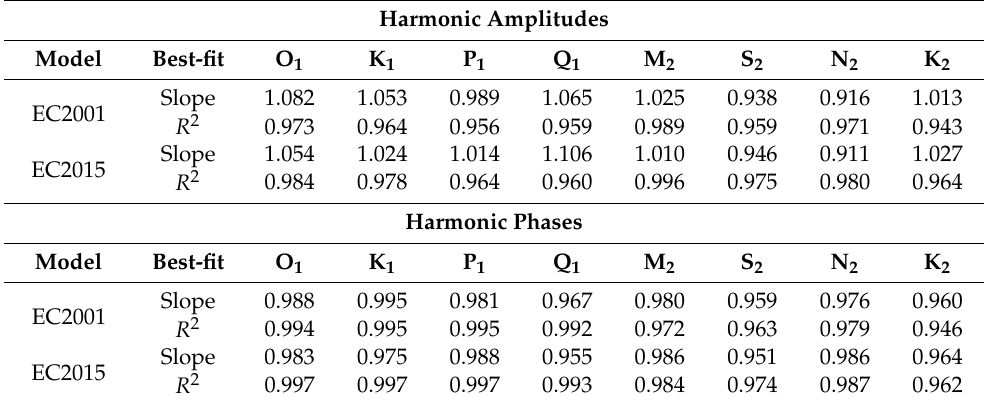
Table 6. Summary of best-fit linear statistics for the 367 common validation stations in the EC2001 and EC2015 tidal